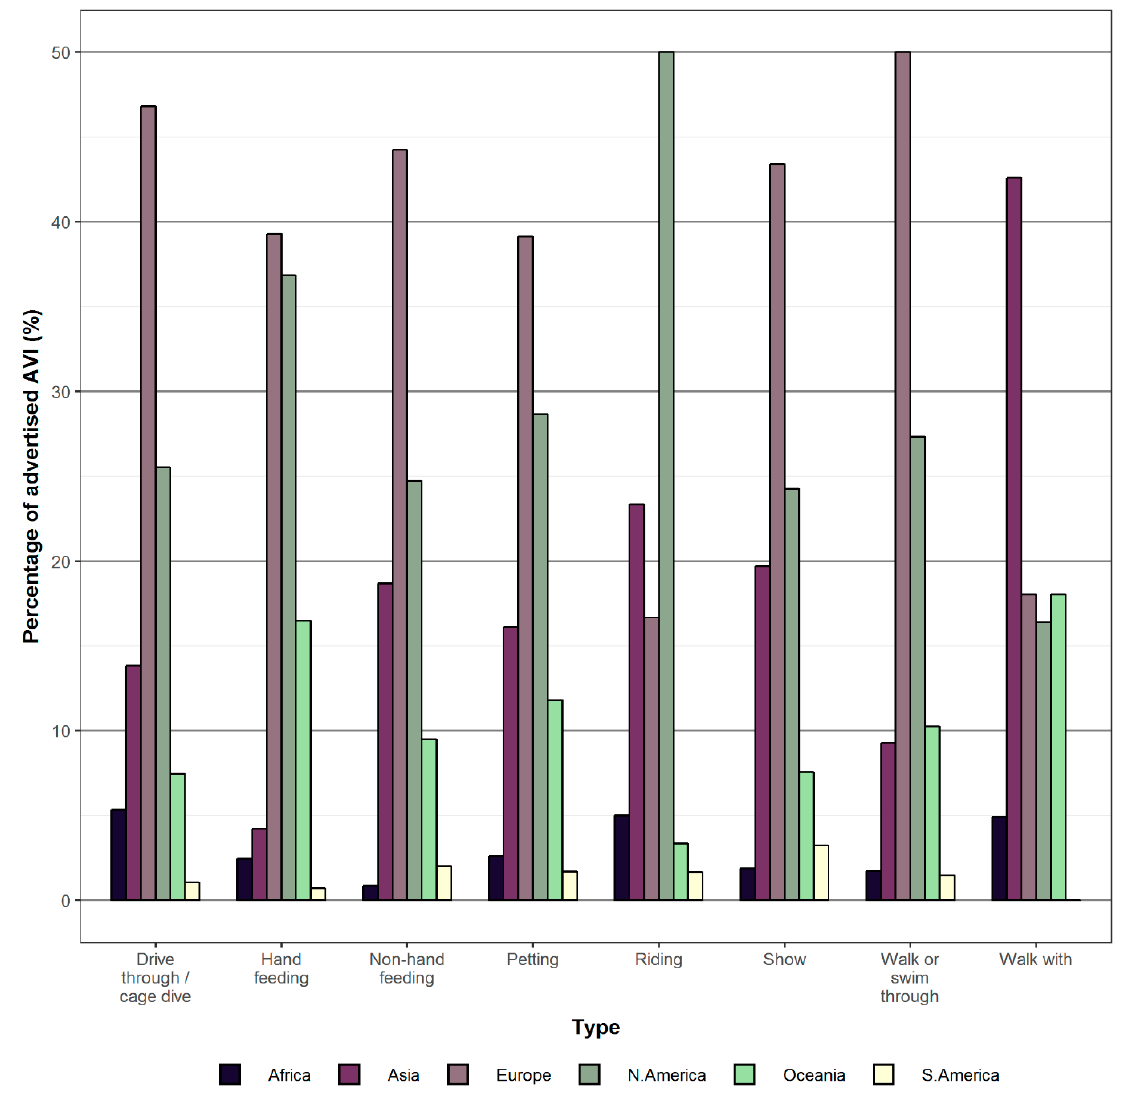
Figure 6. The percentage of advertised AVIs split by region and AVI type.